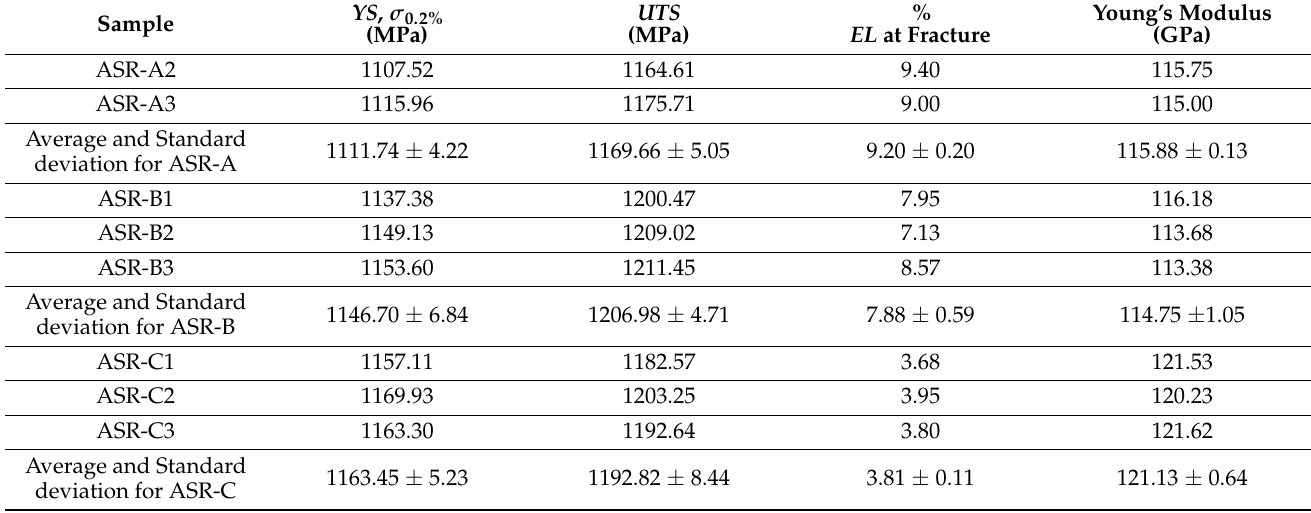
Figure 2. Engineering stress-strain curves obtained from all the Ti-6Al-4V ELI tensile samples: ( a ) as-stress relieved (ASR) and ( b ) hot isostatically pressed (HIP). Table 2. Tensile properties determined from the as-stress relieved (ASR) Ti-6Al-4V ELI alloy samples.